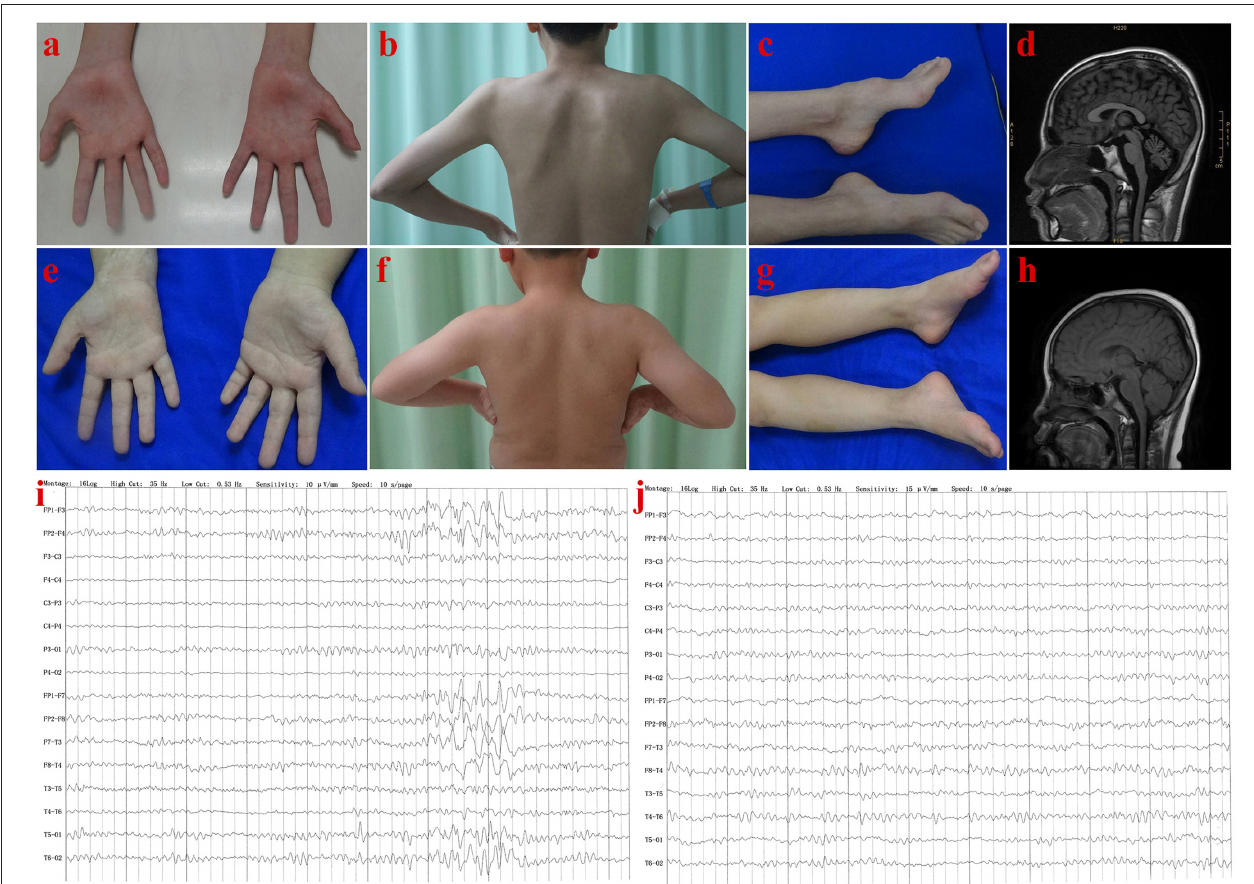
FIGURE 2 | Clinical features of patients in Family 1. Patient III-1: Muscle atrophy in the thenar muscle, interosseous muscle of hands (A) , and shoulder girdle muscle (B) ; bilateral pes cavus (C) ; diffuse cerebellar atrophy on T1-weighted MRI (D) ; EEG showed increased slow waves, paroxysmal sharp-slow wave in the frontal and temporal region (I) . Patient III-2: No muscle atrophy was found in hand (E) , and shoulder girdle muscle (F) , with normal appearance of feet (G) ; T1-weighted MRI of the brain (H) , and EEG (J) were